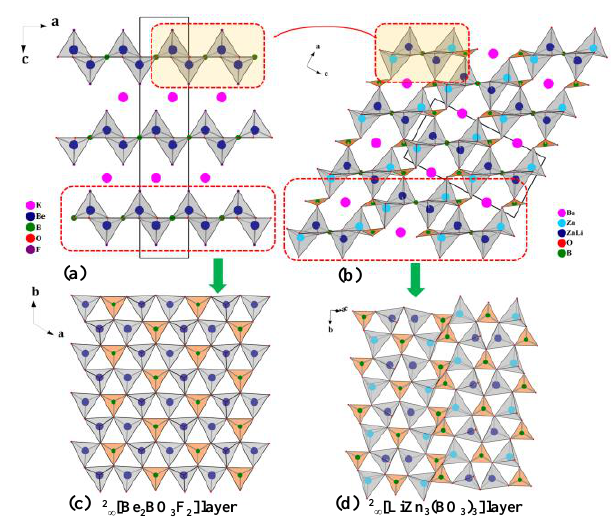
Figure 4. The crystal structures of ( a ) KBe 2 BO 3 F 2 (KBBF) and ( b ) BaLiZn 3 (BO 3 ) 3 viewed along the b -axis; ( c ) The 2 ∞ [Be 2 BO 3 F 2 ] layer in KBBF and ( d ) the 2 ∞ [LiZn 3 (BO 3 ) 3 ] layer in BaLiZn 3 (BO 3 ) 3 . [97]-Reproduced by permission of The Royal Society of Chemistry (RSC) on behalf of the Centre National de la Recherche Scientifique (CNRS) and the RSC.